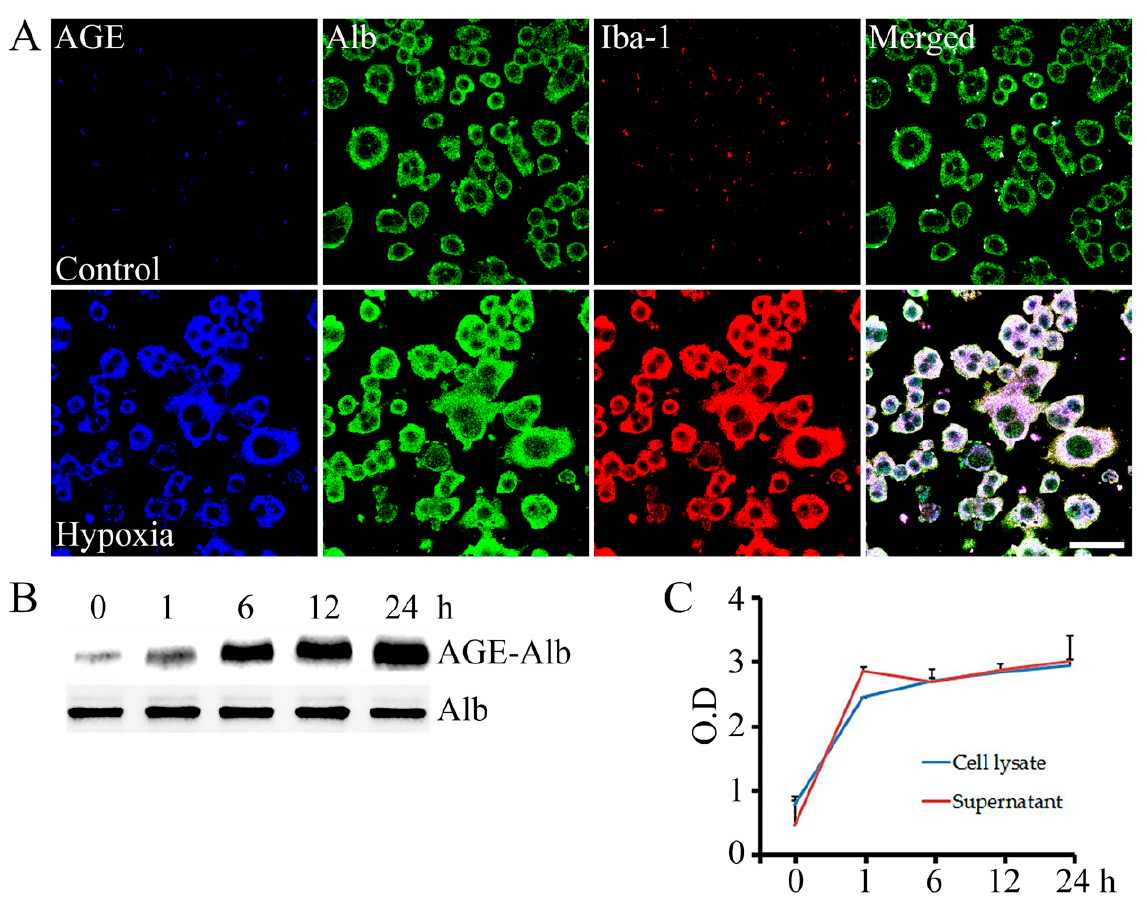
Figure 3. Increased synthesis and secretion of AGE-albumin in activated macrophage cells. ( A ) Triple-labeled confocal microscopic image analyses were used to study the distribution and relative levels of AGE (blue), albumin (green), and Iba-1 (red) in rat macrophage cells after treated with hypoxia- exposed cardiomyocyte conditioned medium. Scale bar = 50 µ m. ( B ) The dose-dependent increases in AGE-albumin in total lysates of RAW cells treated with 0, 1, 6, 12, or 24 h hypoxia-exposed cardiomyocyte conditioned medium for 48 h were determined by co-immunoprecipitation. ( C ) A graph illustrating the dose-dependent changes in intracellular (cell lysates) and extracellular (culture supernatant) levels of AGE-albumin in RAW cells treated with 0, 1, 6, 12, or 24 h hypoxia-exposed cardiomyocyte conditioned medium for 48 h, as determined by